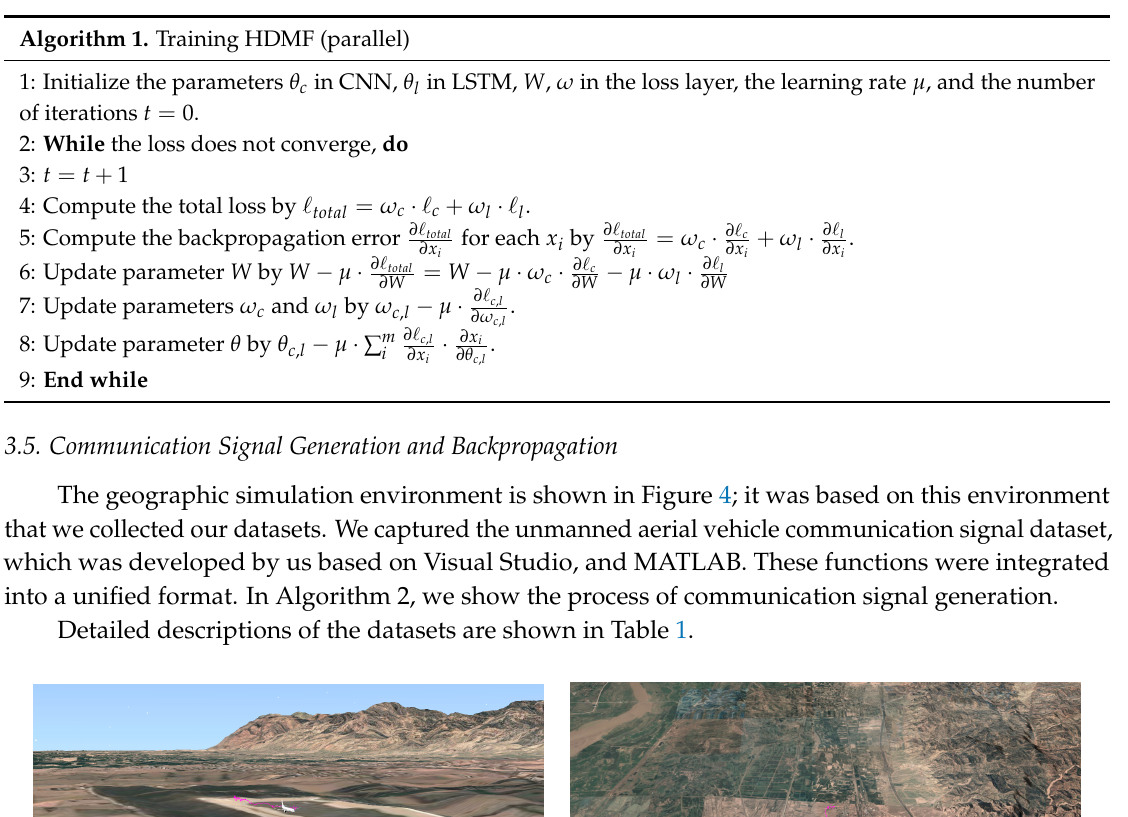
Algorithm 1. Training HDMF (parallel)